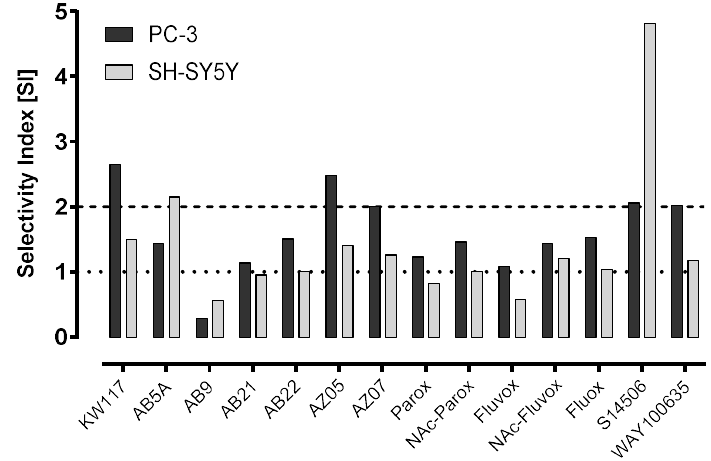
Figure 3. Selectivity index (SI = IC 50 for normal cell line/IC 50 for tumor cell line).